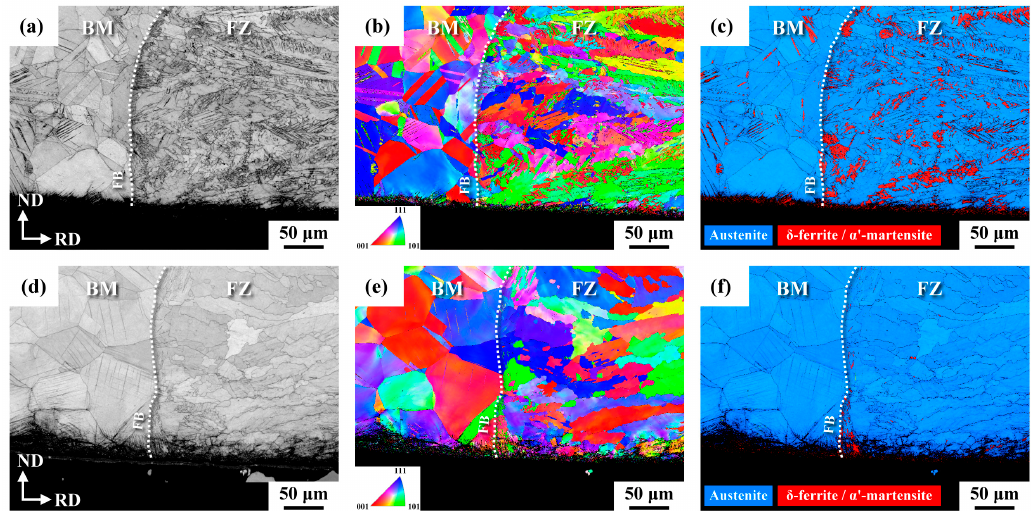
Figure 8. EBSD: ( a ) and ( d ) BC maps, ( b ) and ( e ) IPF maps, ( c ) and ( f ) phase maps of the U-bend samples with micro-shot peening around the FB in cross-sectional view. ( a ), ( b ) and ( c ) the 304 weld; ( d ), ( e ) and ( f ) the 316 weld.